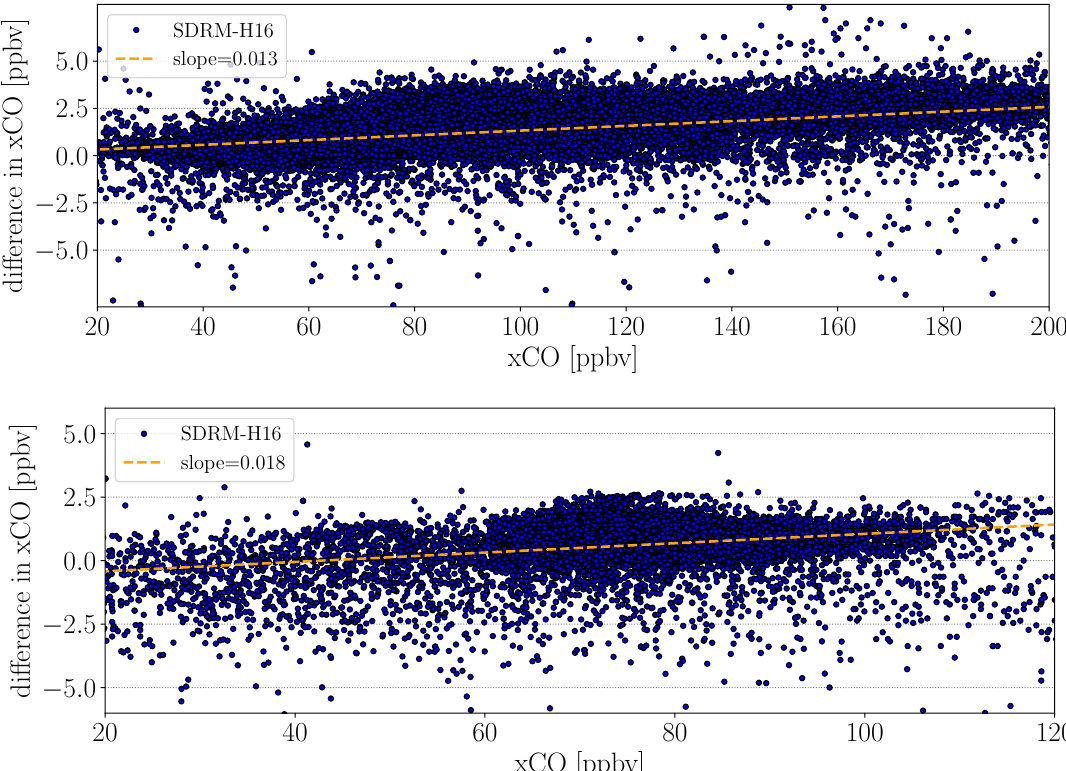
Figure 15. Differences in the retrieved CO mole fractions as a function of the CO concentrations over Amazonia (top) and Central-Europe